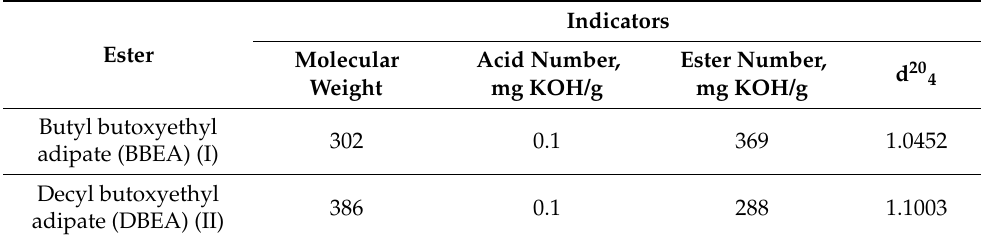
Figure 2. FTIR spectra of decyl butoxyethyl adipate. 3.5. TGA of Esters of Adipic Acid A sample of industrial plasticizer di-2-ethyl hexyl phthalate (DOP) was used as a comparison. It follows from the results of thermal analysis that decyl butoxyethyl adipate is characterized by a higher thermal stability compared to DOP: the temperatures corresponding to the beginning of the decrease in the sample weight upon heating are 153 and 132 °C, respectively. The temperature value corresponding to the maximum decomposition of the product is at a level similar to that for DOP: 278 °C and 285 °C, respectively. The temperatures corresponding to the complete decomposition of the product are 498 °C and 467 °C for DOP. Thermal analysis of the butyl butoxyethyl adipate sample (I) showed that the main listed characteristics, according to the given thermogram, are slightly inferior to DOP (Figures 3–5).